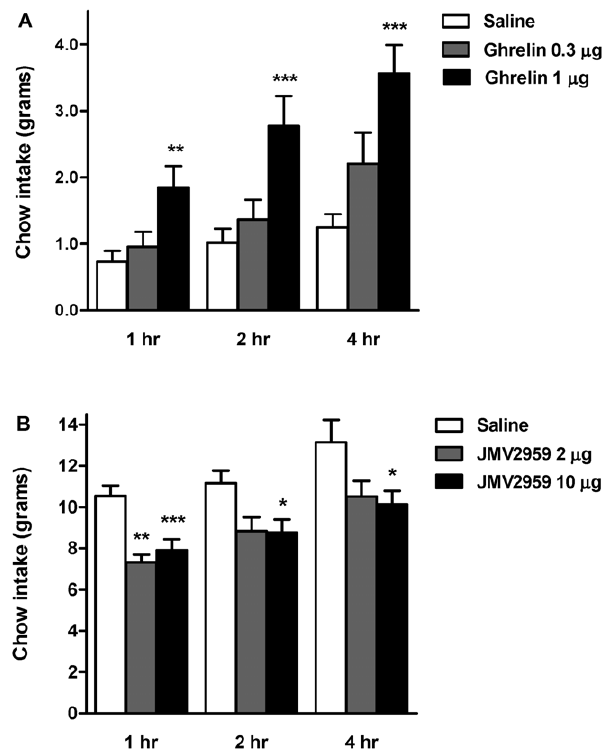
Figure 5. Effects of intra-amygdala administration of ghrelin or a ghrelin antagonist (JMV2959) on cumulative food intake. Normal chow intake was measured at 1, 2, 4, and 24 hr following unilateral intra-amygdala injection of either (A) ghrelin (0.3 and 1 m g) to freely-fed rats or (B) JMV2959 (2 or 10 m g) to overnight fasted rats. Data are expressed as mean 6 S.E.M. *P , 0.05 **P , 0.01 ***P , 0.001, vs. saline. Paired sample t-test, SPSS.